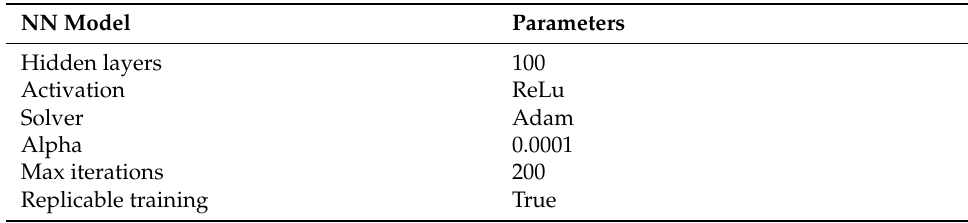
Table 5. The parameters of NN